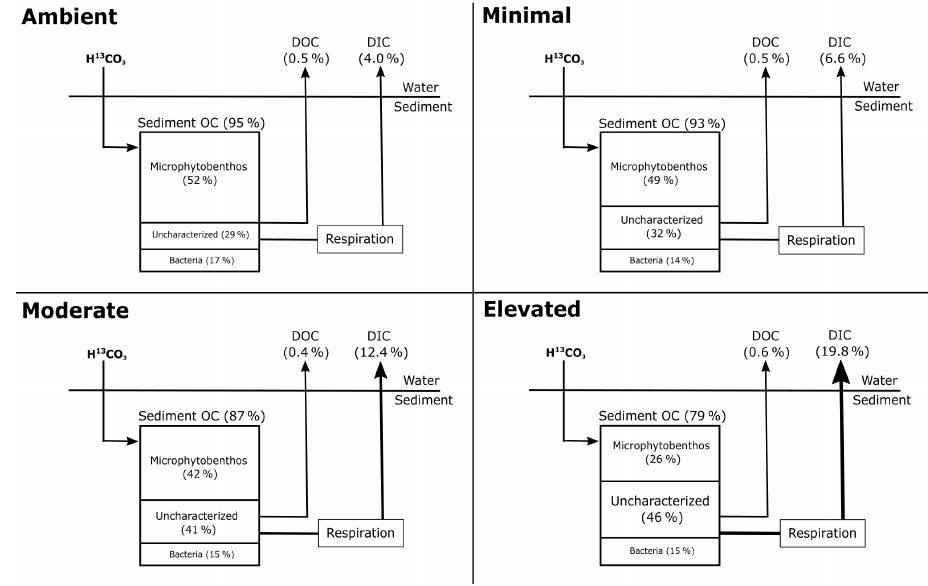
Figure 7. Distribution of 13 C at 3.5 days of incubation of inundated sediment including loss pathways for DIC and DOC. The 13 C contained in sediment organic carbon (sediment OC) is further partitioned into microphytobenthos, bacteria, and uncharacterized organic carbon as a percentage of the 13 C in sediment organic carbon at 0–10cm 3.5 days after labeling (Figure layout from Eyre et al.,